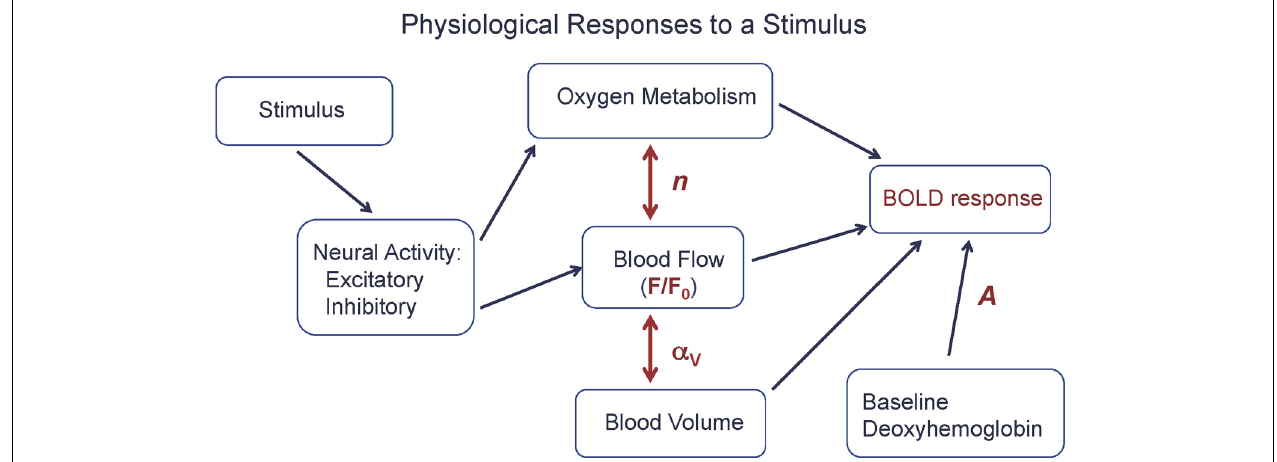
FIGURE 1 | The physiological basis of the BOLD response. A stimulus evokes increased excitatory and inhibitory neural activity, with the energy cost of the net evoked activity met primarily by an increase in oxygen metabolism (CMRO 2 ), with increased blood flow (CBF) driven by aspects of the neural response. The BOLD response is primarily driven